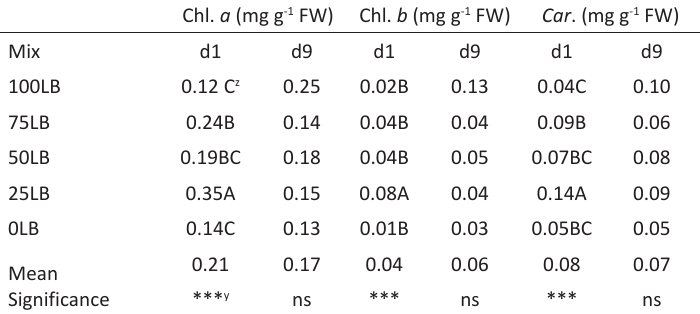
Table 2. Chlorophyll a (Chl. a ), chlorophyll b (Chl. b ) and carotenoid ( Car .)